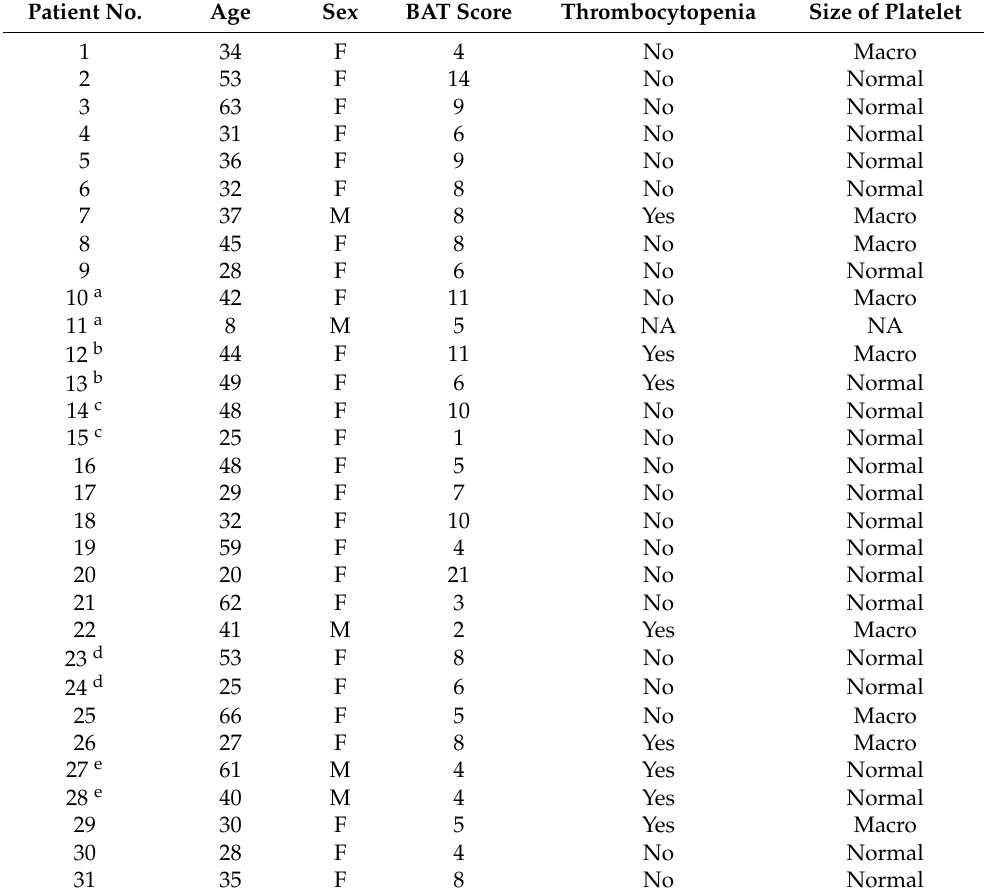
Table 1. Patients’ Bleeding Assessment Tool (BAT) scores and platelet morphological features. Patient